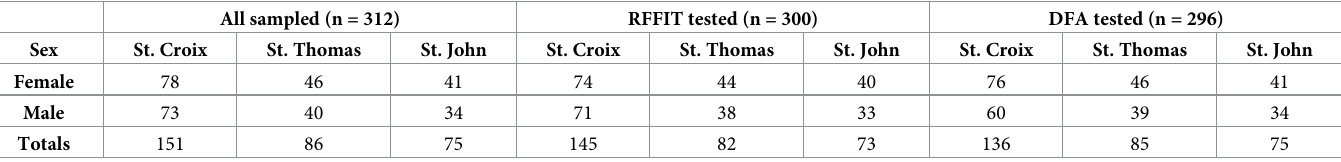
� All mongoose serum and brain samples tested negative for rabies antibody by using the rapid fluorescent focus inhibition test ( < 0.05 IU/ml), and rabies antigen by using the direct fluorescent antibody test,